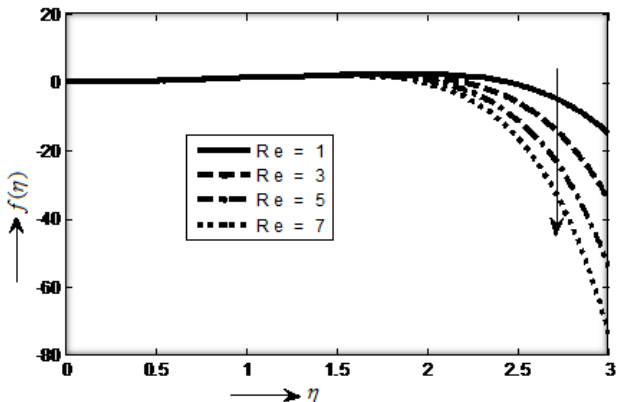
Figure 5. Variation of fluid velocity f (  ) with respect to  for Reynolds Numbers Re (1, 3, 5, 7) by taking parameters M = 2, K = 0.8 and  =0.5